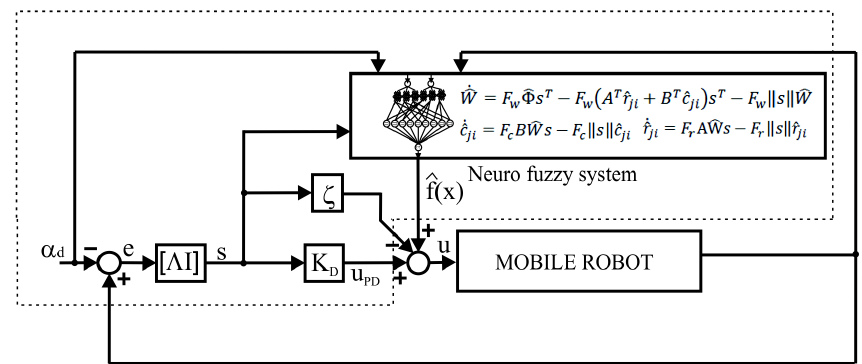
Figure 1: Schematic of the neuro-fuzzy control system for a wheeled mobile robot